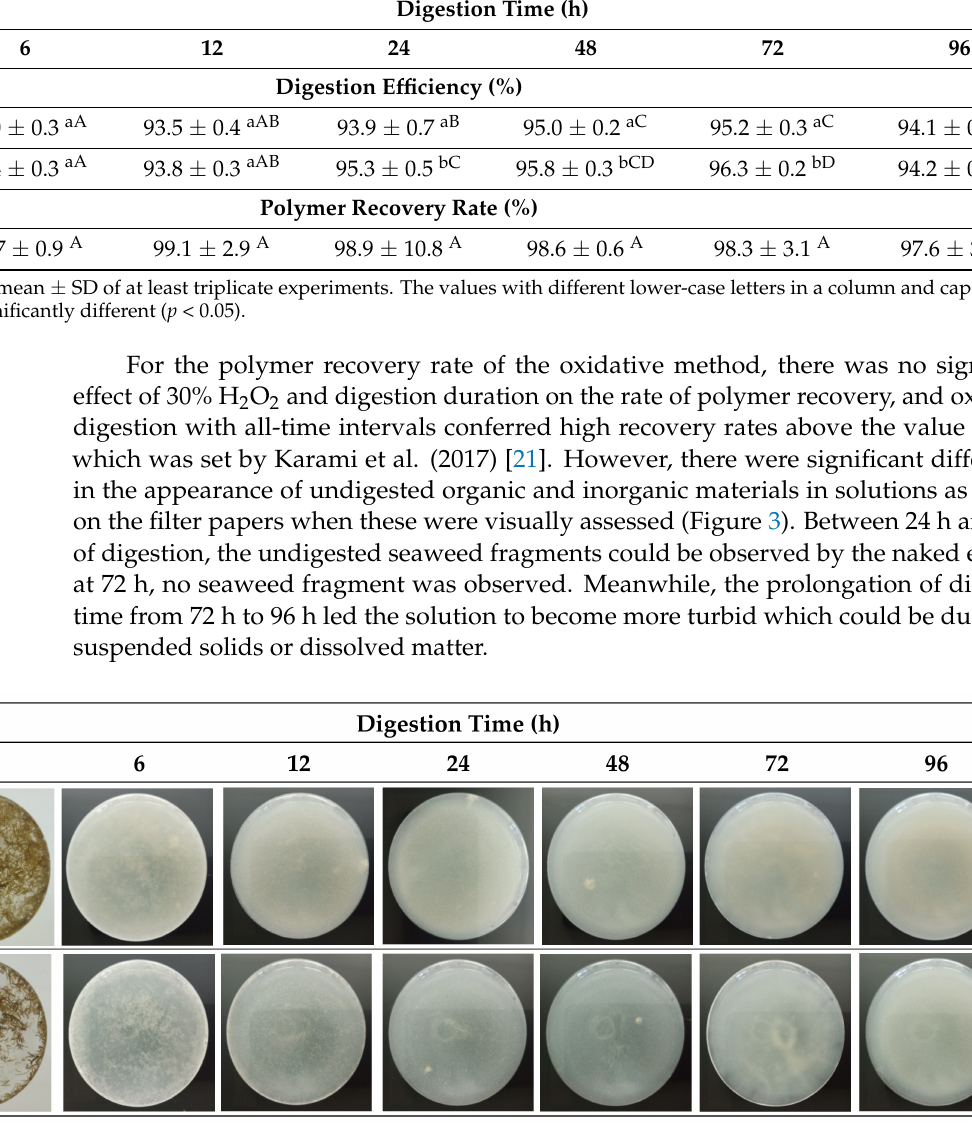
Figure 3. Appearance of dried G. fisheri after oxidative digestion. Bottom view of the digestate in a 250 mL Erlenmeyer